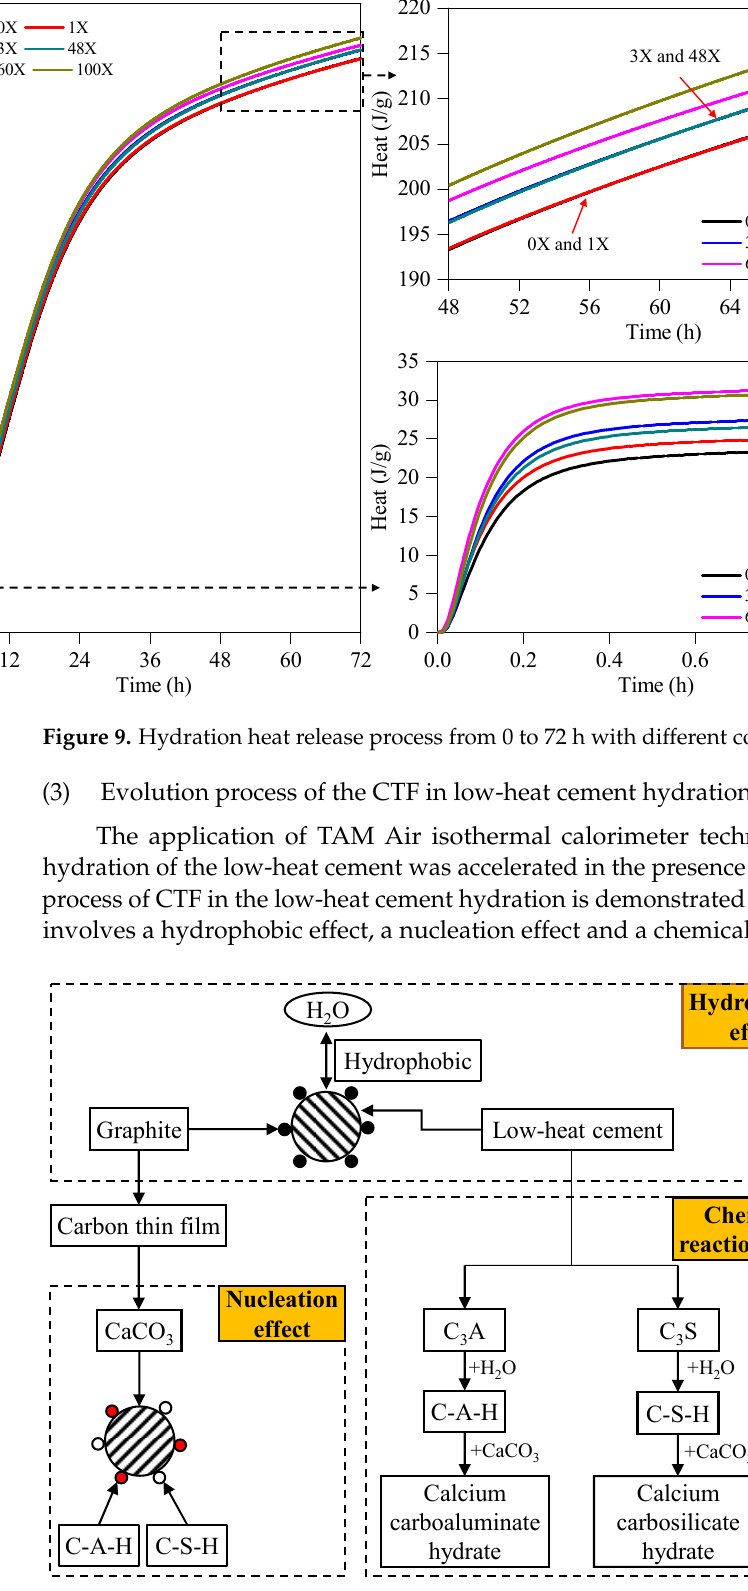
Figure 10. The evolution process of the CTF in low-heat cement hydration.